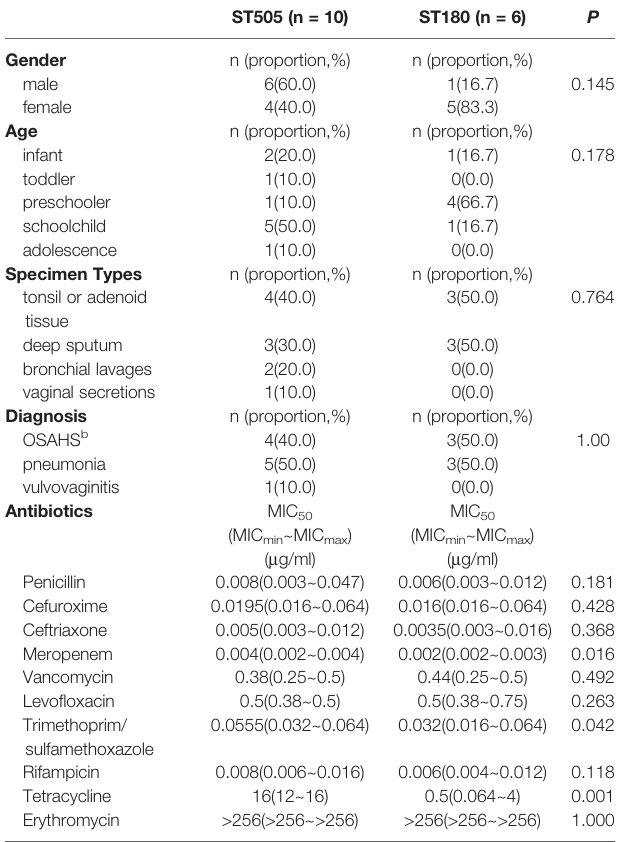
TABLE 3 | Differences of clinical and microbiological characteristics between ST a 505 and